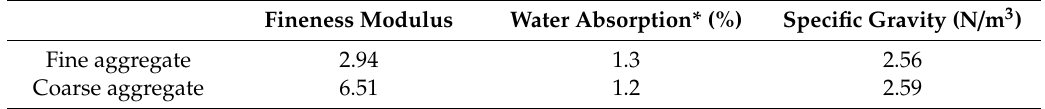
Table 2. Physical properties of the fine and coarse